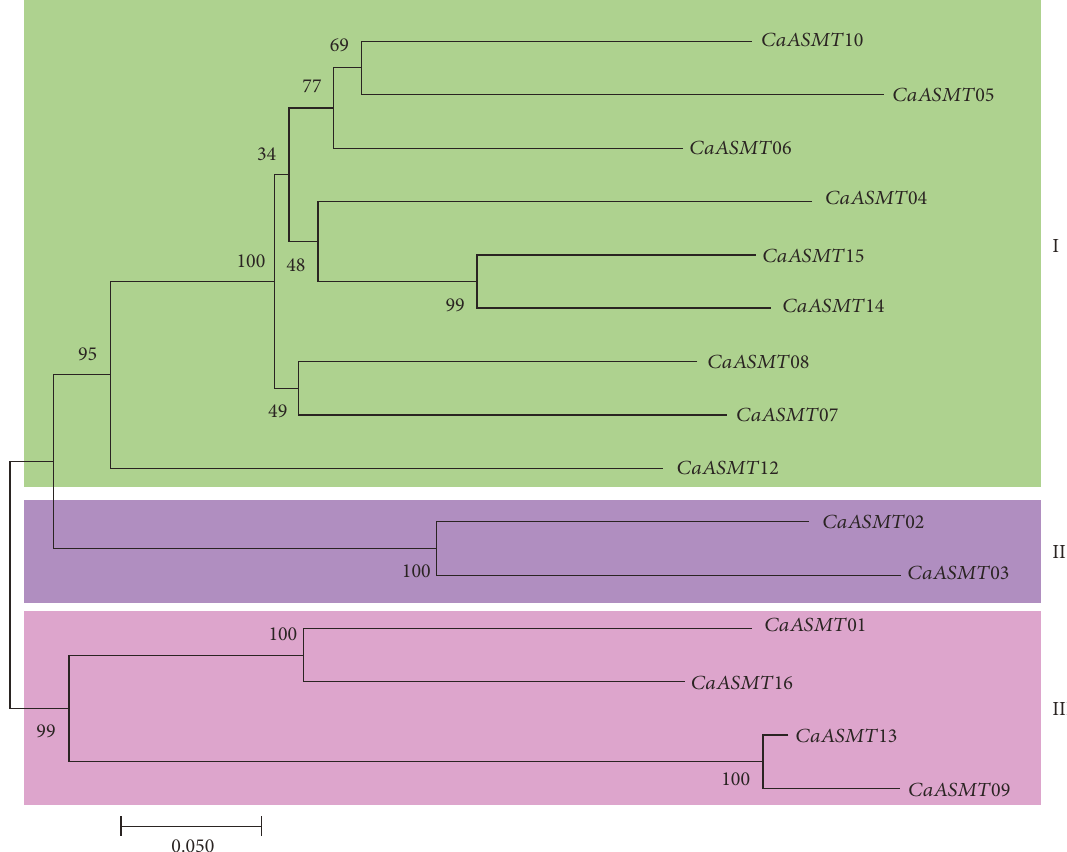
Figure 1: Phylogenetic analysis of the CaASMT gene family in pepper plants. Phylogenetic tree of the CaASMT genes was constructed using MEGA7.0, and the CaASMT genes were divided into two, groups I and